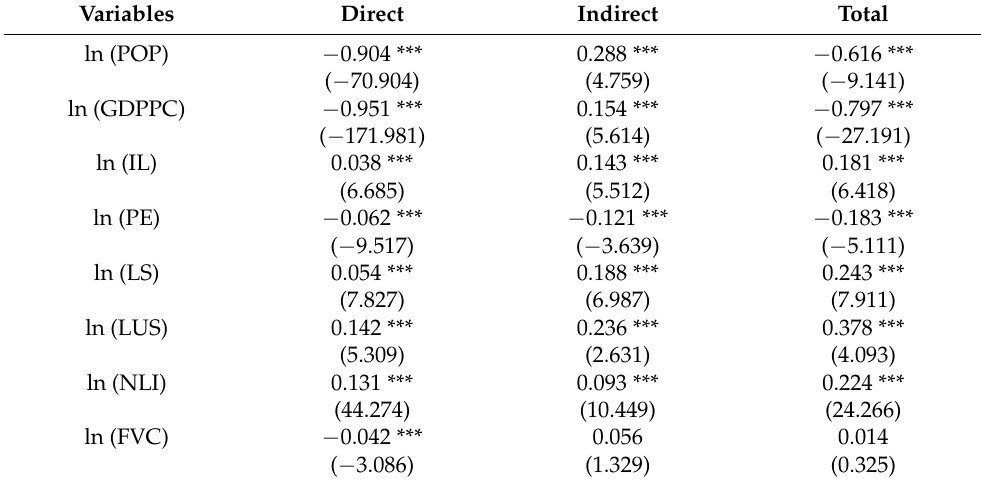
Table 5. Direct and indirect effects